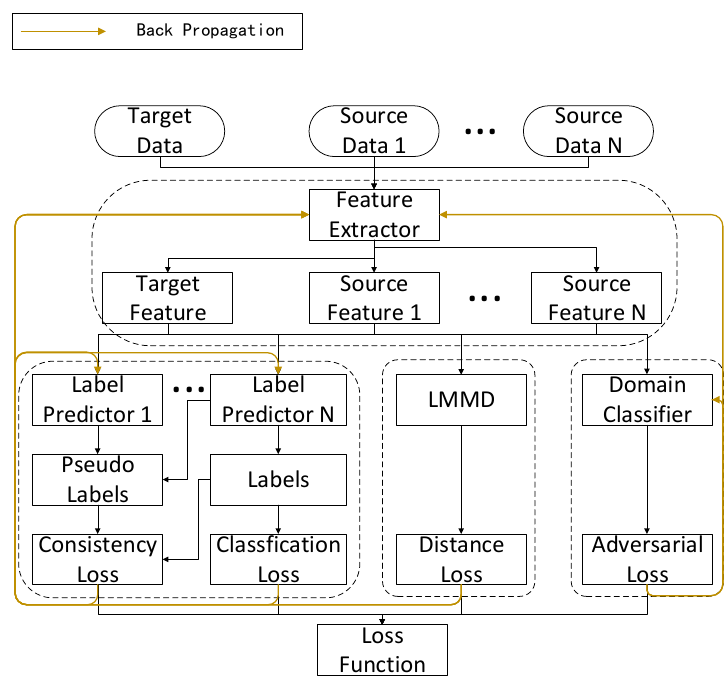
Figure 1. MCDANN